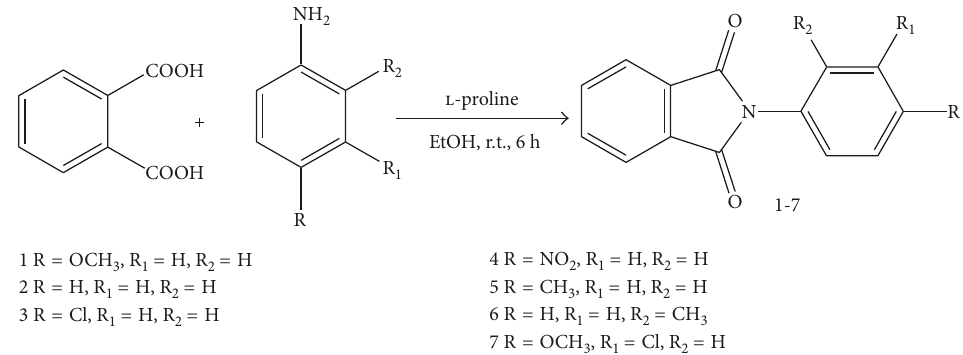
Scheme 1: Synthesis of phthalimide derivatives 1 – 7 .